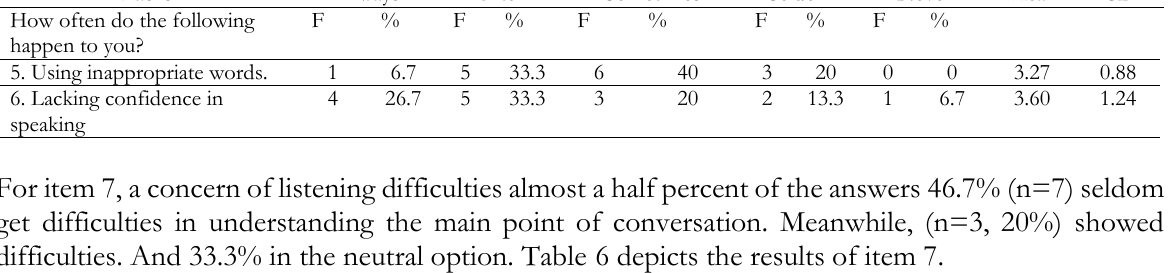
TABLE 6. Students’ perception of their listening